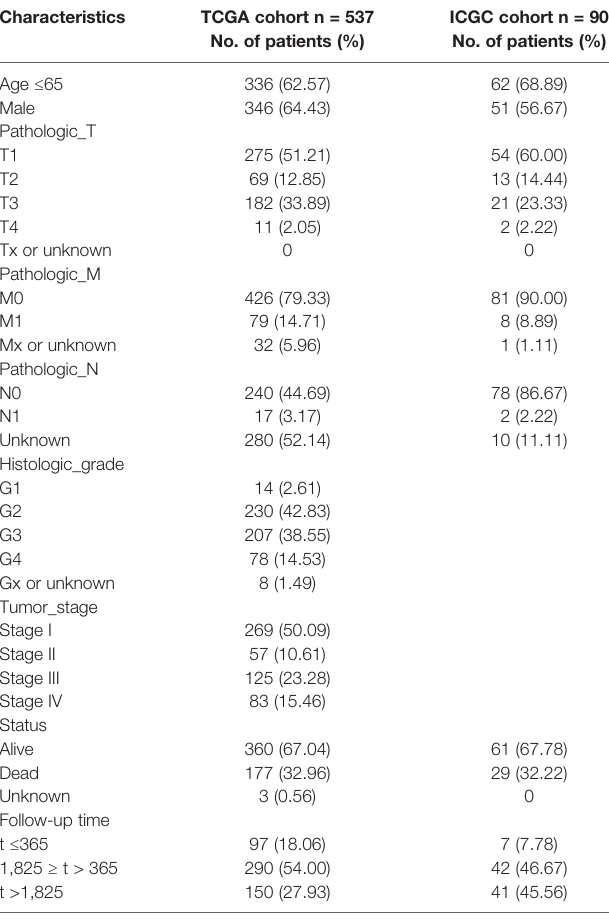
TABLE 1 | Baseline characteristics of enrolled